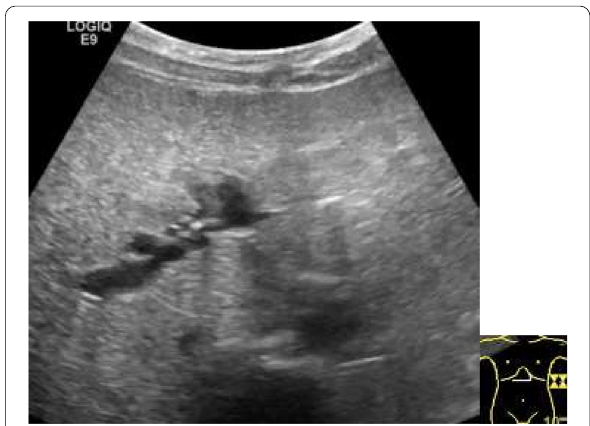
Fig. 5 Echography on readmission. Abdominal echography on readmission shows a spotted high echoic pattern in